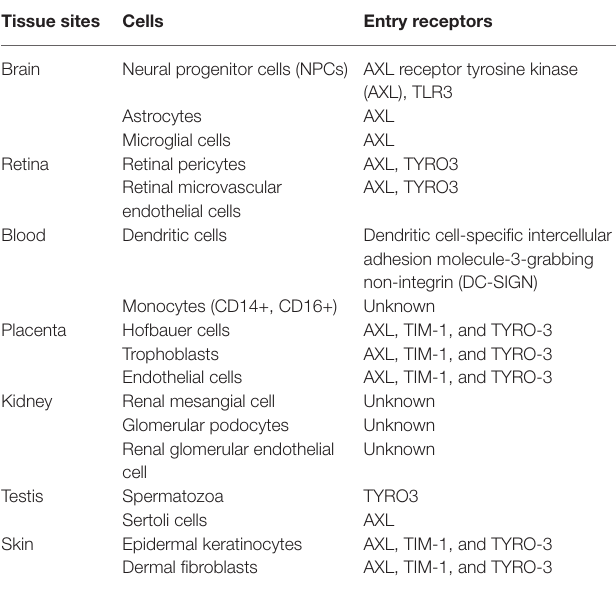
TABLE 1 | Host cell entry receptors targeted by ZIKV (Lee et al., 2018; Lee and Shin, 2019). Tissue sites